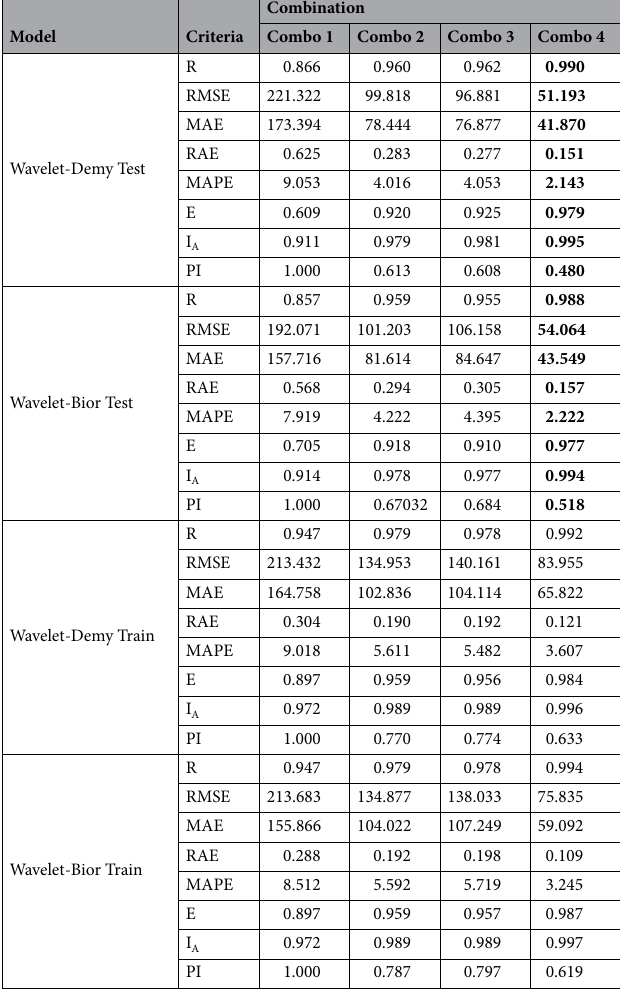
Table 7. Statistic metrics obtained by W-ANFIS-A-DEPSO model to forecast the EC parameter for all combinations. Significant values are in